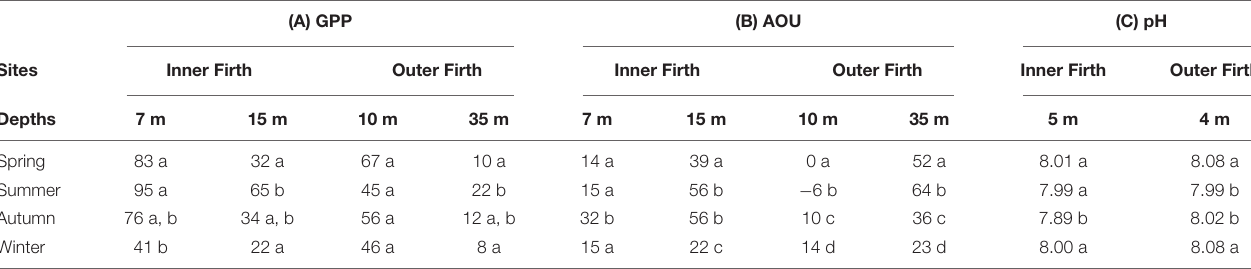
TABLE 1 | Seasonal medians for biophysical mooring data, at inner and outer Firth sites ( Figure 1B ) for (A) Gross Primary Production (GPP: mg C m − 3 d − 1 ), (B) Apparent Oxygen Utilisation (AOU: µ mol O 2 kg − 1 ) at upper and lower water column depths (m) and (C) pH [ - log(H + )] at upper water column